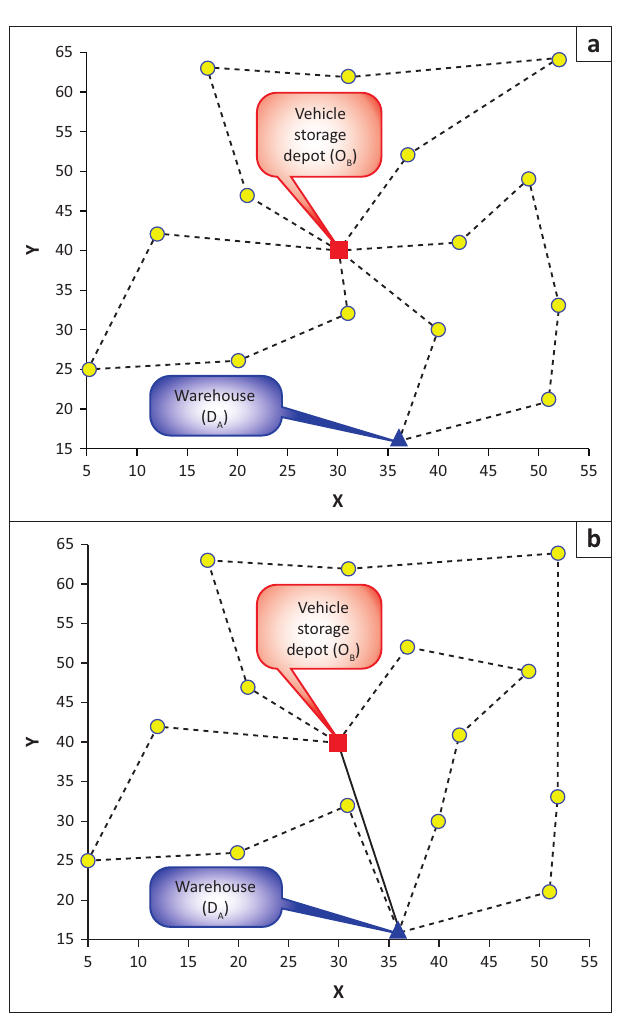
FIGURE 3: (a) Capacitated Vehicle Routing Problem (CVRP) and (b) Capacitated Vehicle Routing Problem for Carriers (CVRPfC) – Routing planning with the Capacitated Vehicle Routing Problem and Capacitated Vehicle Routing Problem for Carriers models, for 15 nodes, 3 vehicles and vehicle capacity of 90 units (test problem name E16-03m